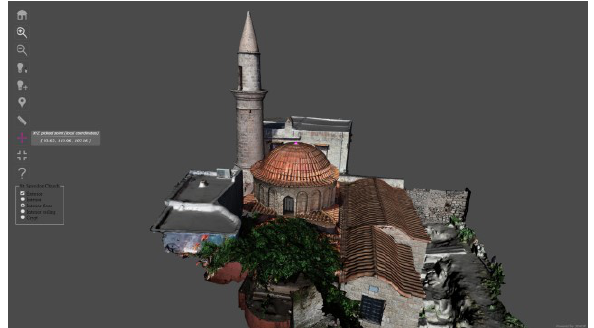
Figure 11. Screenshot of the "Measure" tab in the 3DHOP